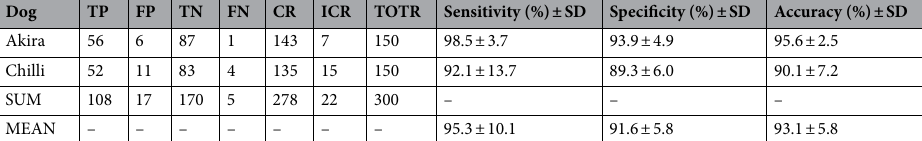
Table 3. Mean results presented as sensitivity, specificity and accuracy in percent, including ± standard deviation (SD), calculated from 30 randomized and double-blind experimental searches carried out on trees and untreated wooden pallets in field condition between 26th of July to 10th of July 2020 at the University of Southeast Norway and forest areas in close vicinity of the University including both invasive and native wood borers. A dog`s response to a sample could be either; TP true positive response, FP false positive response, TN true negative response and FN false negative response. CR total number of correct responses, ICR total number of incorrect responses, and TOT R total number of